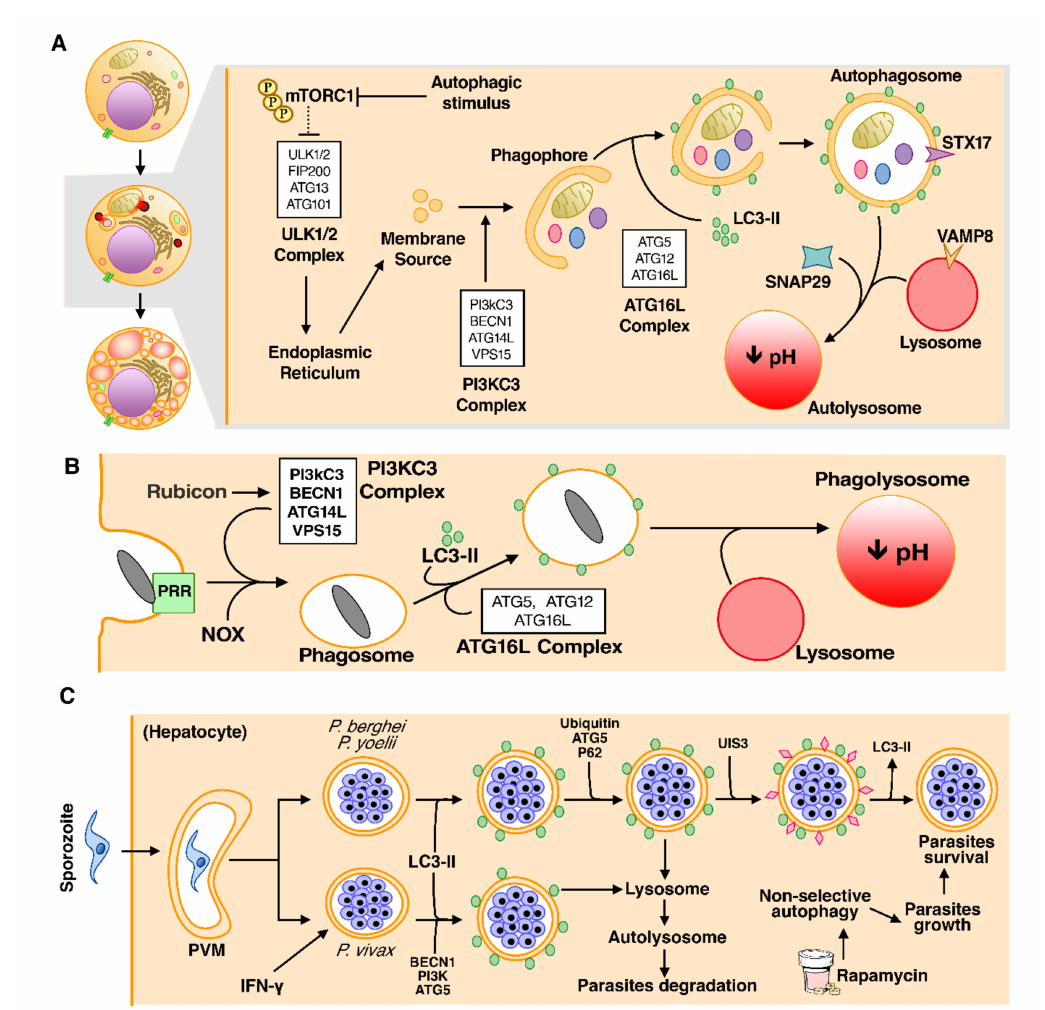
Figure 3. The different forms of autophagy can either act as a defense mechanism of the host or enhance the growth of the parasite. ( A ) The macroautophagy pathway, the non-selective form of autophagy. On the left side of the figure (white background), morphologically, autophagic cell death presents no changes in cell size, but is characterized by the accumulation of autophagosomes. On the right, the molecular mechanism of macroautophagy. ( B ) The LC3-associated phagocytosis (LAP) pathway, an unconventional form of autophagy that has some particularities, like the formation of a single membrane vesicle. ( C ) Different faces of autophagy in malaria infection. Host’s autophagic machinery recognizes parasitophorous vacuole membrane (PVM) and initiates the LAP-like pathway to degrade parasites. However, the Plasmodium relies on the UIS3 protein to remove LC3-II from the PVM and prevent LAP-like autophagy. In addition, pharmacological induction of autophagy induces the non-selective autophagic cell death of uninfected hepatocytes, which contributes to the growth of